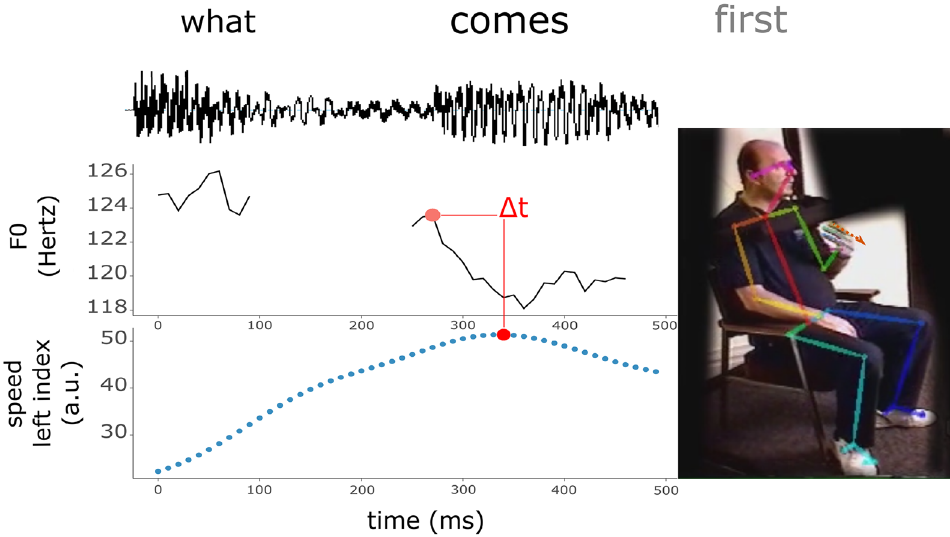
Figure 2. Gesture-speech synchrony timing estimation example. Note. Example of a gesture produced during the 1998 retelling of “canary row” cartoon wherein IW introduced the next scene “what comes first”, with an empathic stress on “comes”. Note that the first word has a higher peak F0. Given that this peak is further from peak speed the timing will be computed for the peak F0 nearest to it (i.e., the peak F0 of the second syllable).